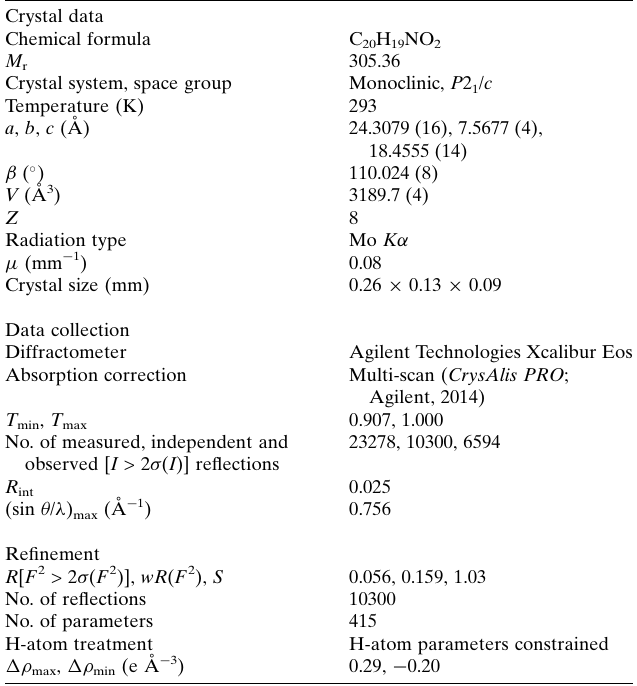
Table 3 Experimental details. Crystal data Chemical